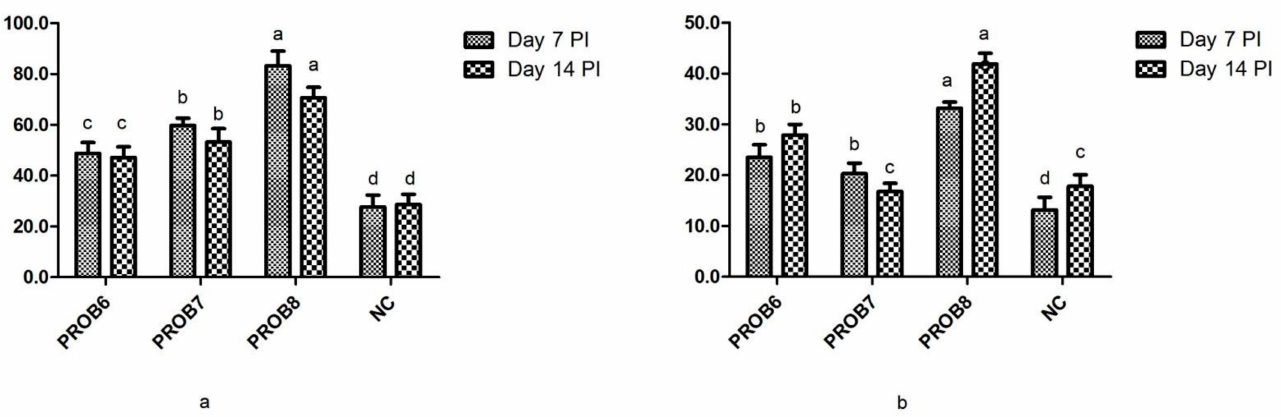
Figure 5. Humoral response to SRBCs in different probiotic-supplemented and control group: ( a ) total immunoglobulin (Ig) at 7 and 14 days post infection (PI); ( b ) IgG assessment at 7 and 14 days post infection (PI). Means with different superscripts (a, b, c, d) are significantly different ( p < 0.05). PROB6 = L. plantarum (1 × 10 6 CFU) supplemented group in feed; PROB7 = L. plantarum (1 × 10 7 CFU) supplemented group in feed; PROB8 = L. plantarum (1 × 10 8 CFU) supplemented group in feed; NC = infected, non-medicated control